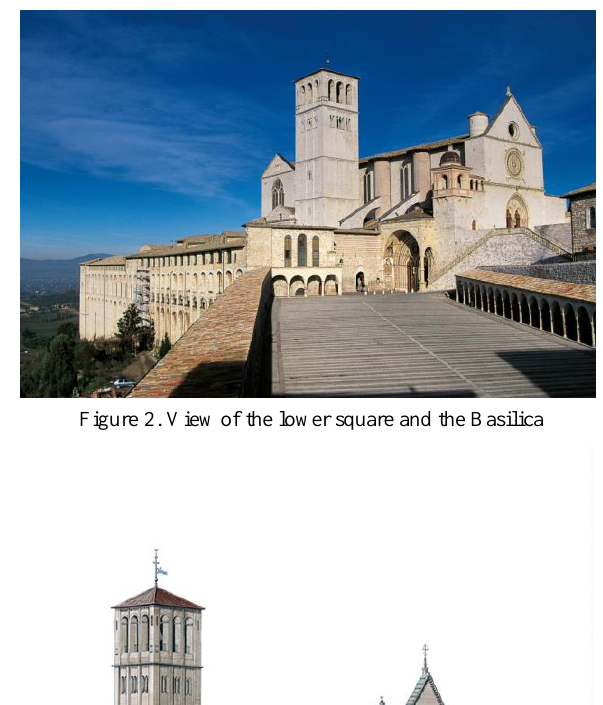
Figure 2. View of the lower square and the Basilica